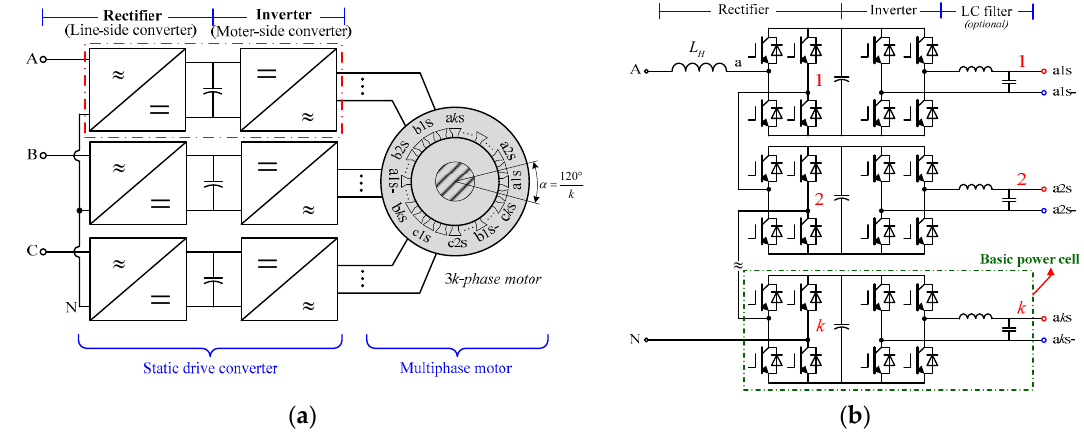
Figure 1. The proposed transformerless medium ‐ voltage multiphase motor drive system. ( a ) Drive system; ( b ) The detailed configuration of the static converter (phase A).